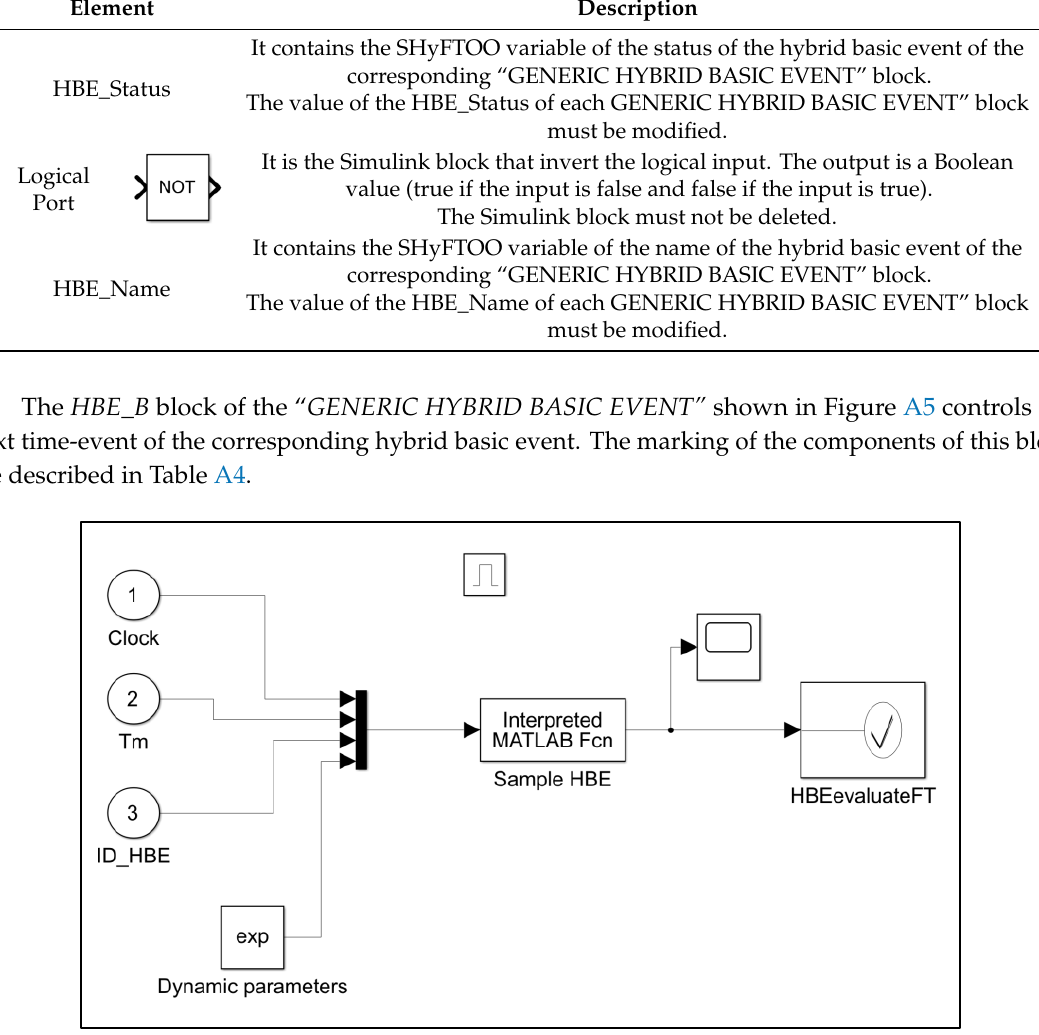
Table A4. Marking of the components of the HBE Simulink block.